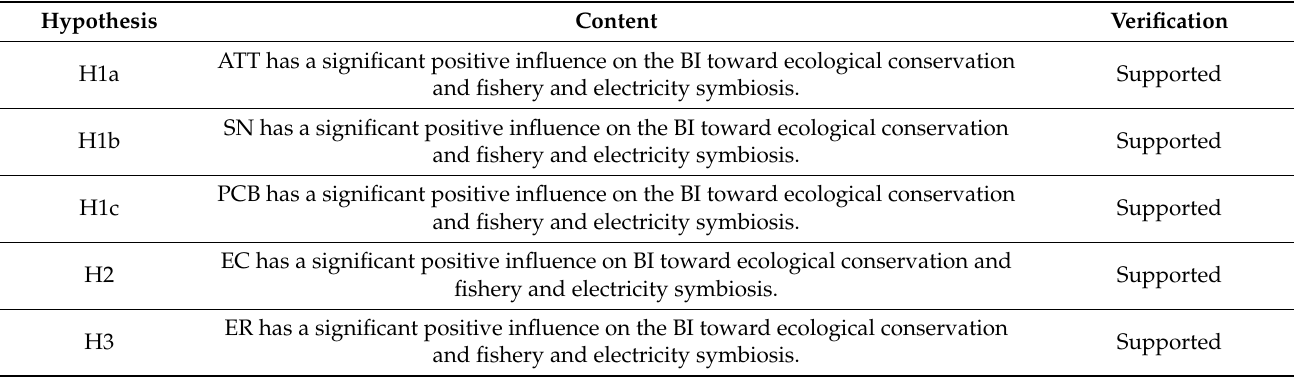
Table 3. Summary of hypothesis